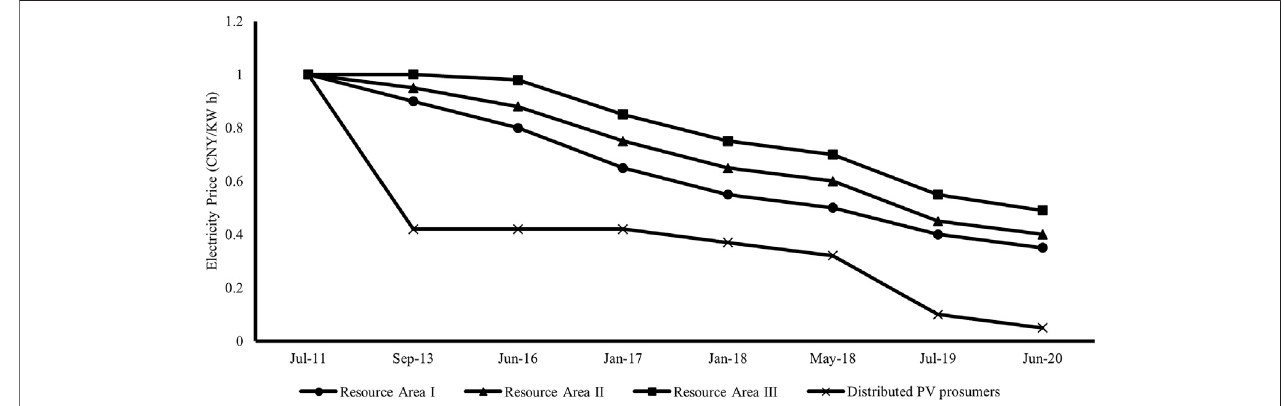
FIGURE 2 | FIT and guidance price of centralized PV and full on-grid distributed PV power stations and subsidy standard for distributed PV prosumers.